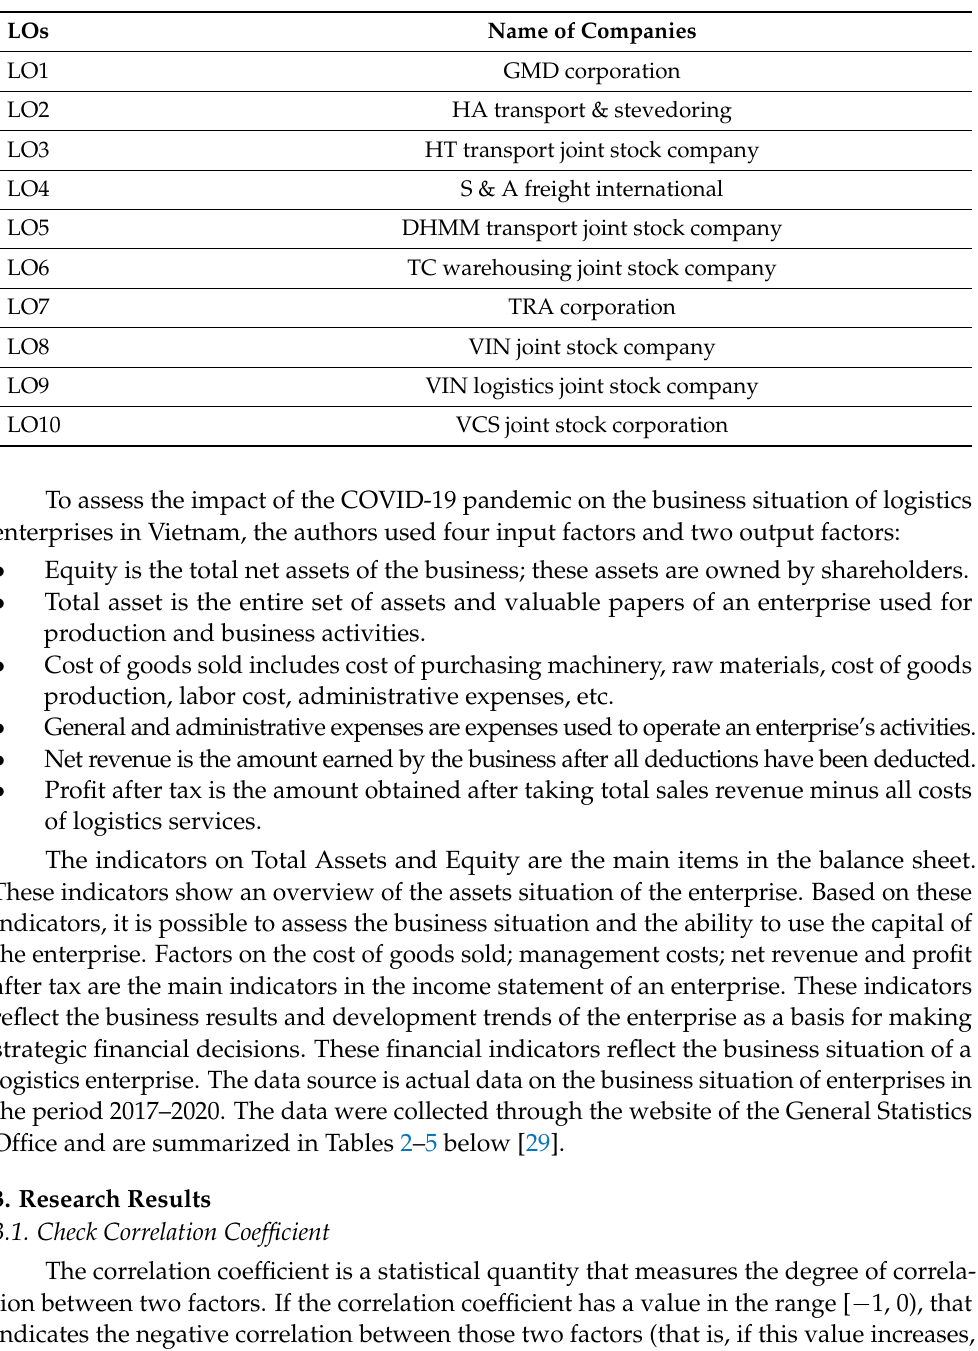
Table 1. List of LOs (Statistics